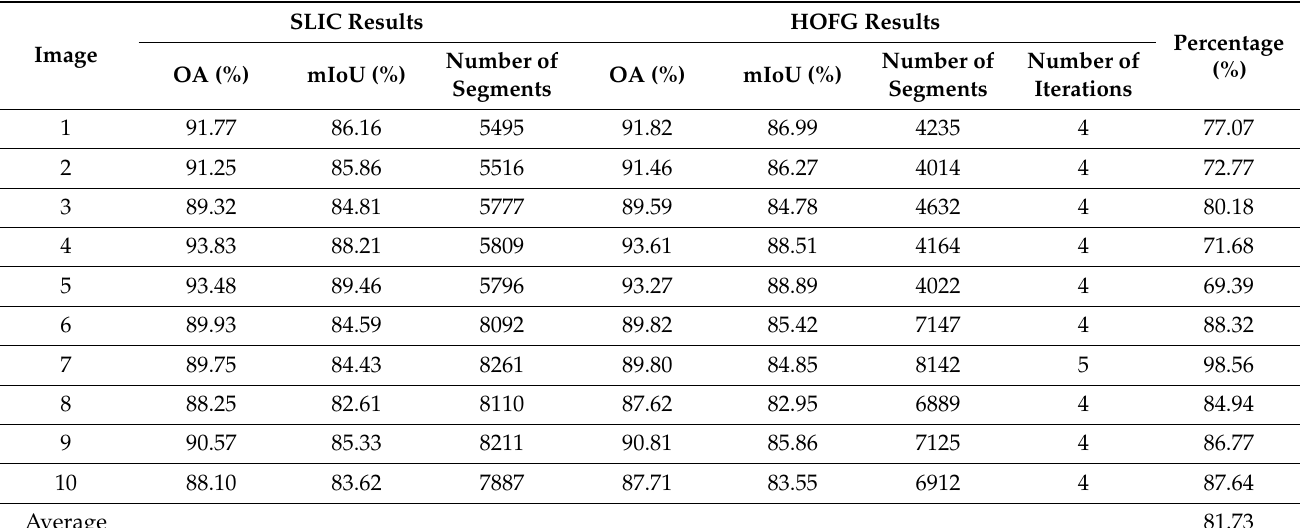
Table 7. Comparison of SLIC and HOFG results on 10